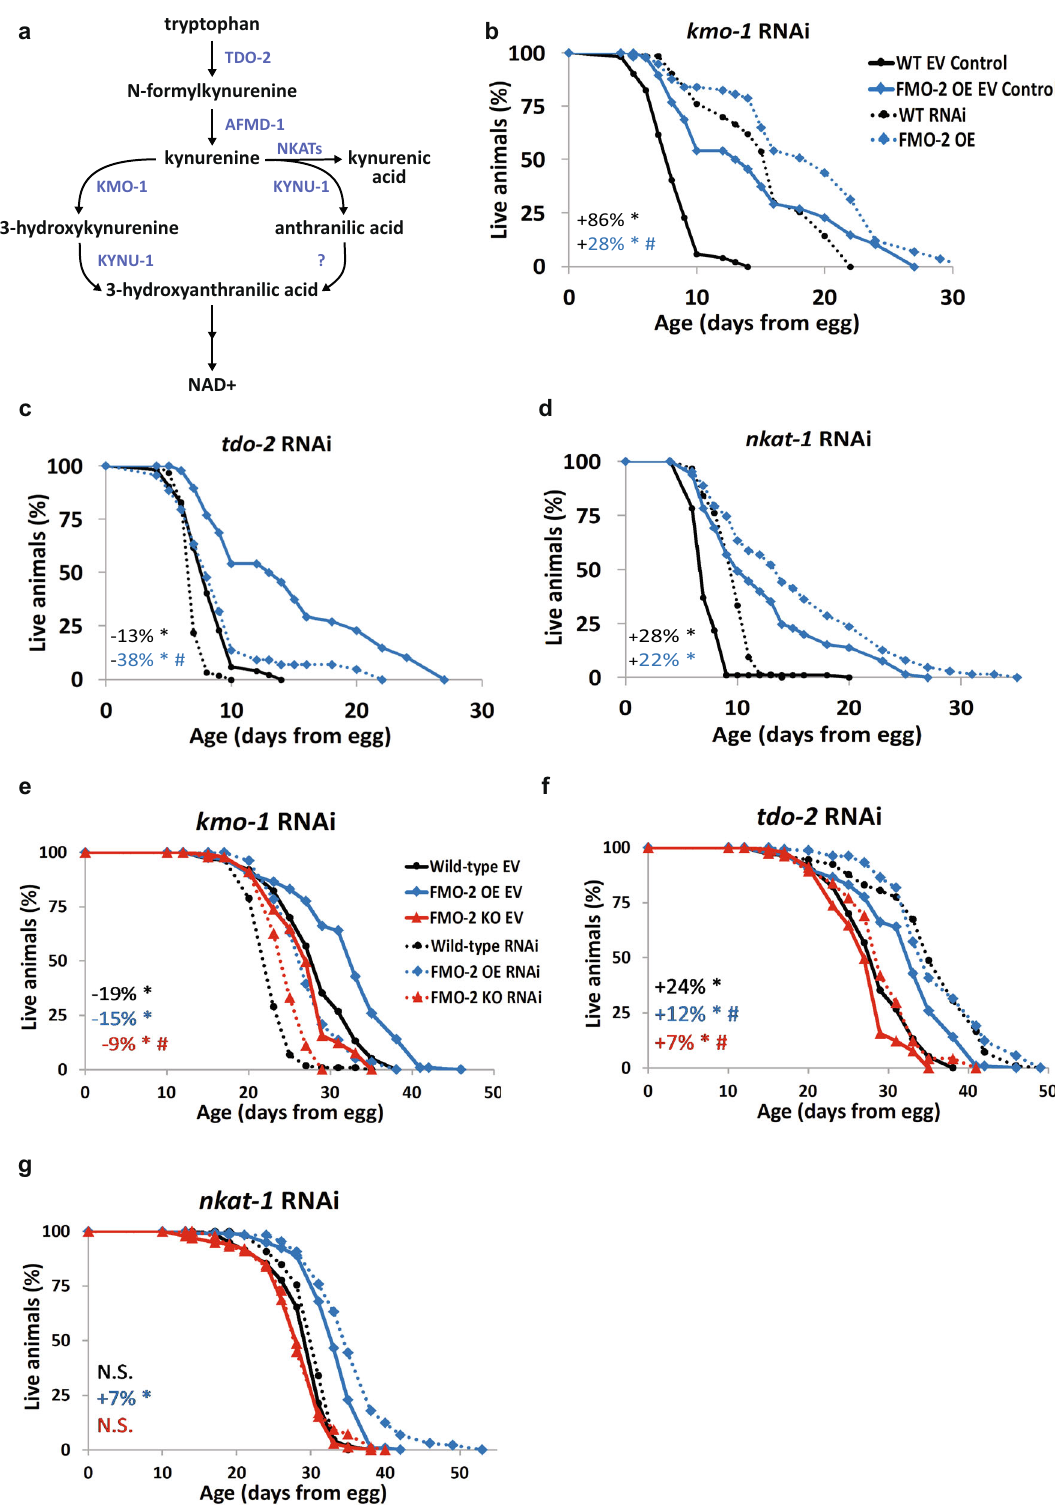
Fig. 5 | Fmo-2 interacts with kynurenine metabolism to regulate stress resis- tance and lifespan. a Diagram of the kynurenine pathway. 5mM paraquat stress resistance assay comparing the wild type and FMO-2 OE on empty-vector (EV) and b kmo-1 RNAi, c tdo-2 RNAi, and d nkat-1 RNAi. Lifespan assay comparing the survivalofthewildtype,FMO-2OE,andFMO-2KOonEV,and e kmo-1 RNAi, f tdo-2 RNAi, and g nkat-1 RNAi. Percent change in mean lifespan compared to their respective EV controls are shown in the left bottom corner of the fi gures. Black